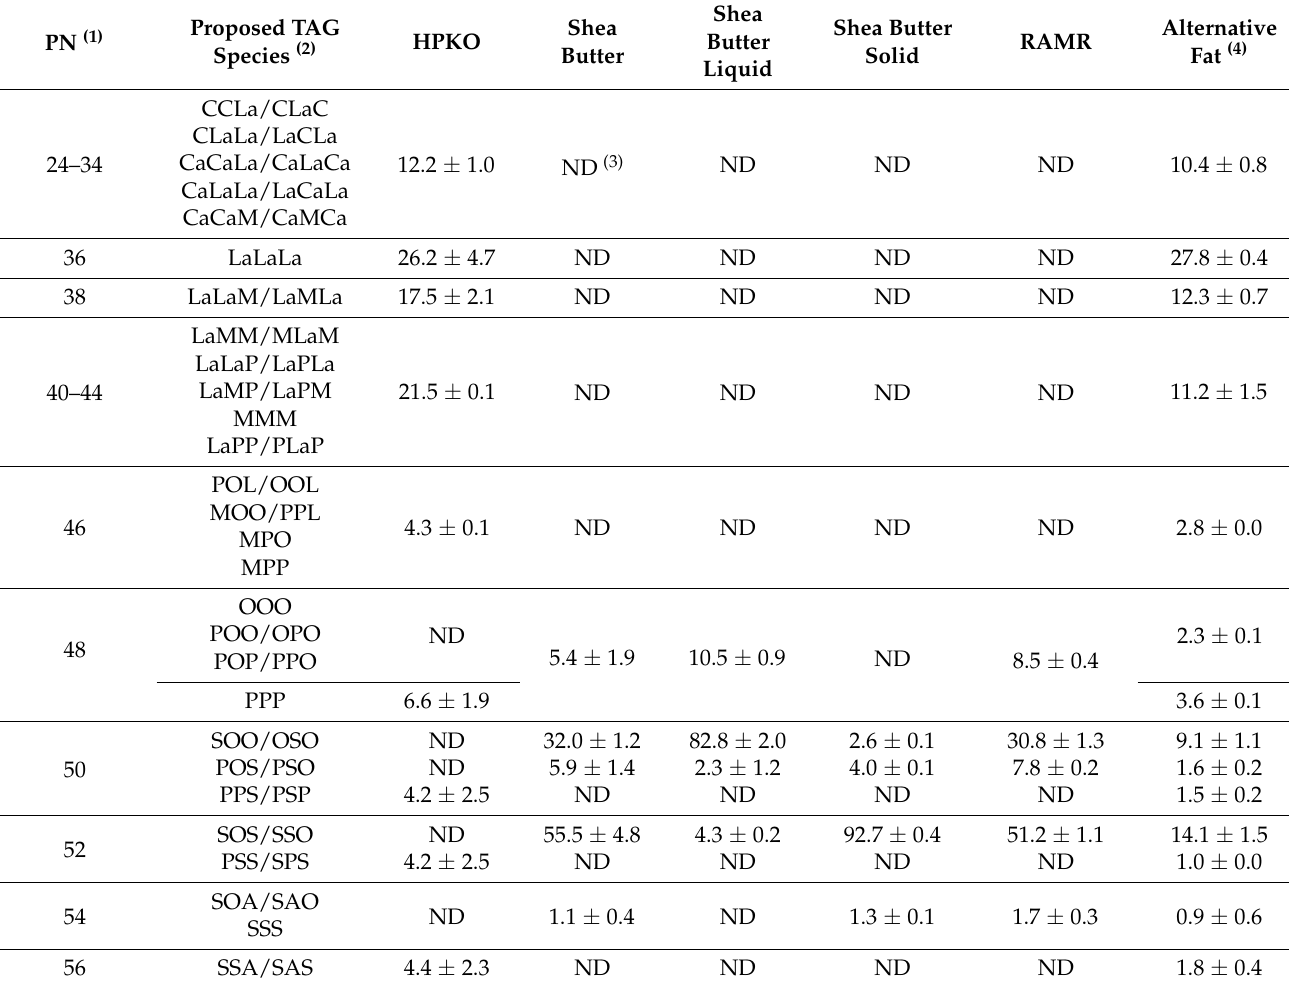
Table 2. Proposed triacylglycerol (TAG) molecular species of hydrogenated palm kernel oil (HPKO), shea butter, shea butter liquid, shea butter solid, refined acyl migration reactant (RAMR), and alternative fat analyzed by reversed-phase HPLC. (Unit: